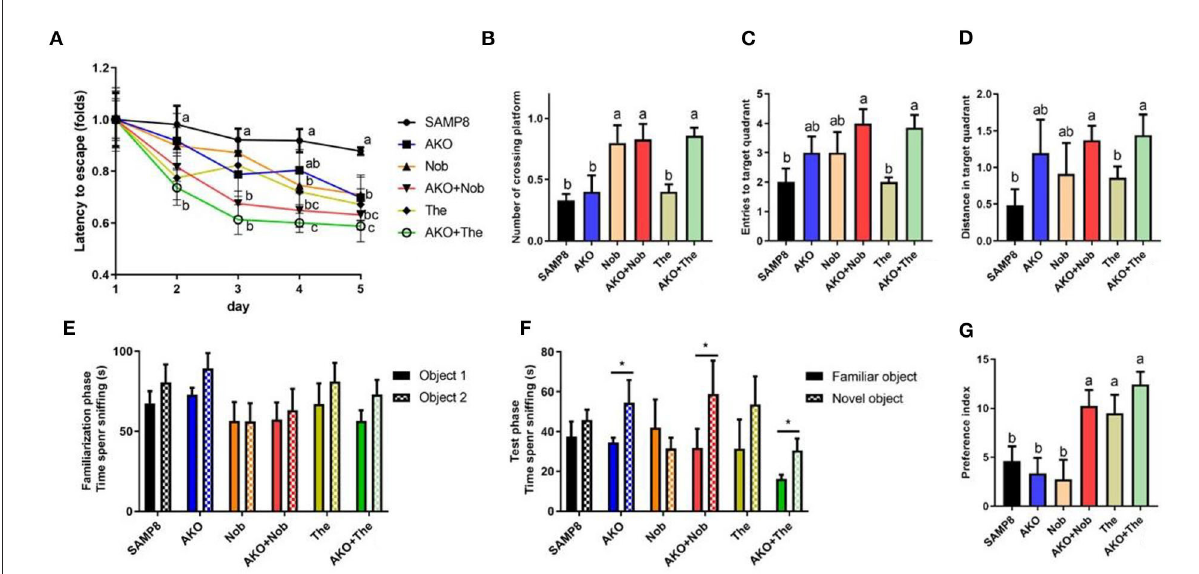
FIGURE1 Effects on memory and cognitive deficiency indicated by performance in the Morris water maze test (A–D) and the novel object recognition test (E–G) . (A) Latency to escape to the platform during the place navigation test. (B) The number of platform crossings. (C) The entries to the target quadrant. (D) The distance traveled in the target quadrant. (E) The time spent sniffing two objects in the familiarization phase. (F) The time spent sniffing two objects in the test phase. (G) Increase of the preference index in two stages. All data were presented as mean ± standard error of the mean (SEM). Different letters indicate a significant difference at p < 0.05 by analysis of variance (ANOVA), and * indicates a significant difference at p < 0.05 by t -test.